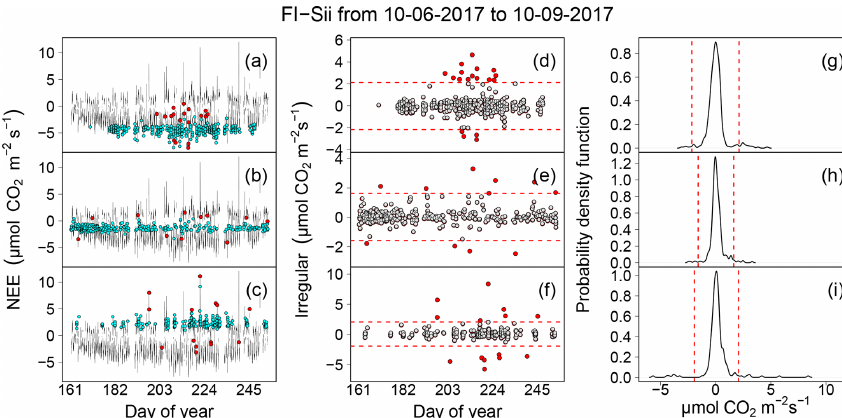
Figure 14. Illustrative example of the outlier detection procedure applied to NEE fluxes at the FI-Sii site. NEE time series for the whole period (black lines) and selected flux values according to three deciles of the extracted signal (coloured points) are shown in (a) – (c) . The corresponding values of the Irregular component are shown in (d) – (f) , while their probability density functions are depicted in (g) – (i) . Dashed red lines indicate the α -outlier regions ( α = 0 . 01) assuming a Laplace distribution. Red points indicate the detected